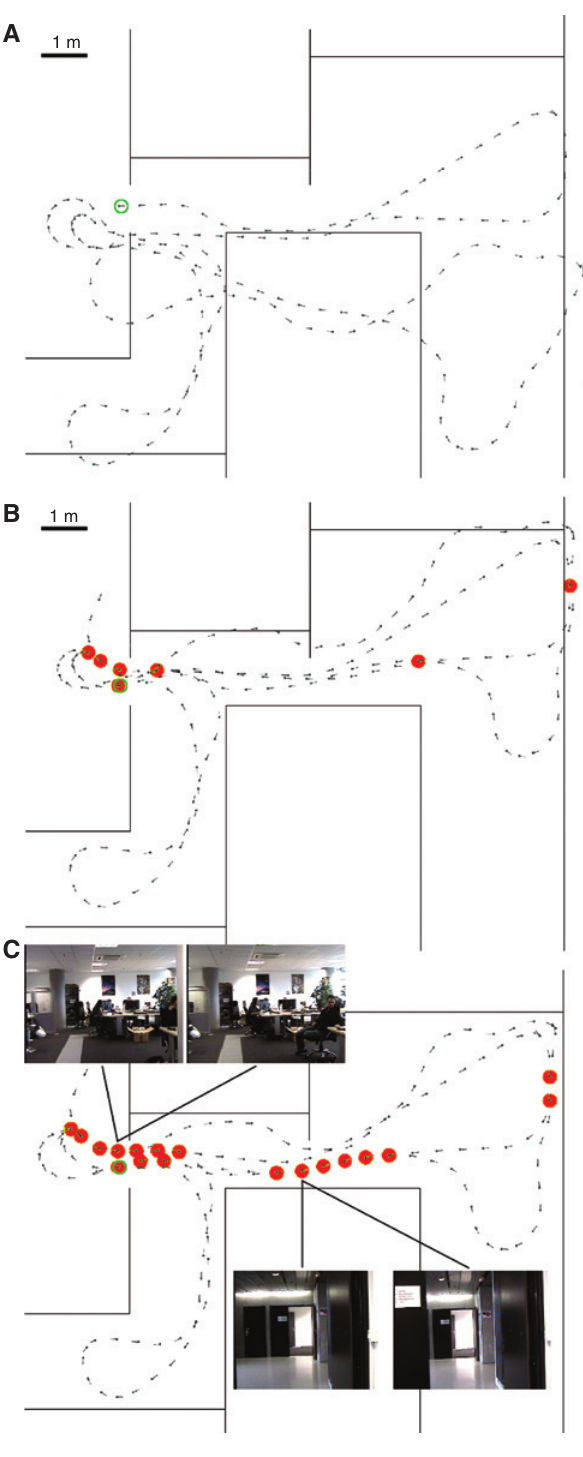
Figure 10. Gostai Sequence: Example of Topometric Mapping Results. (A) Raw odometry; (B) topometric map using the loop-closure framework from Ref. [2] (7 loop closures); (C) map using the pro- posed model (18 loop